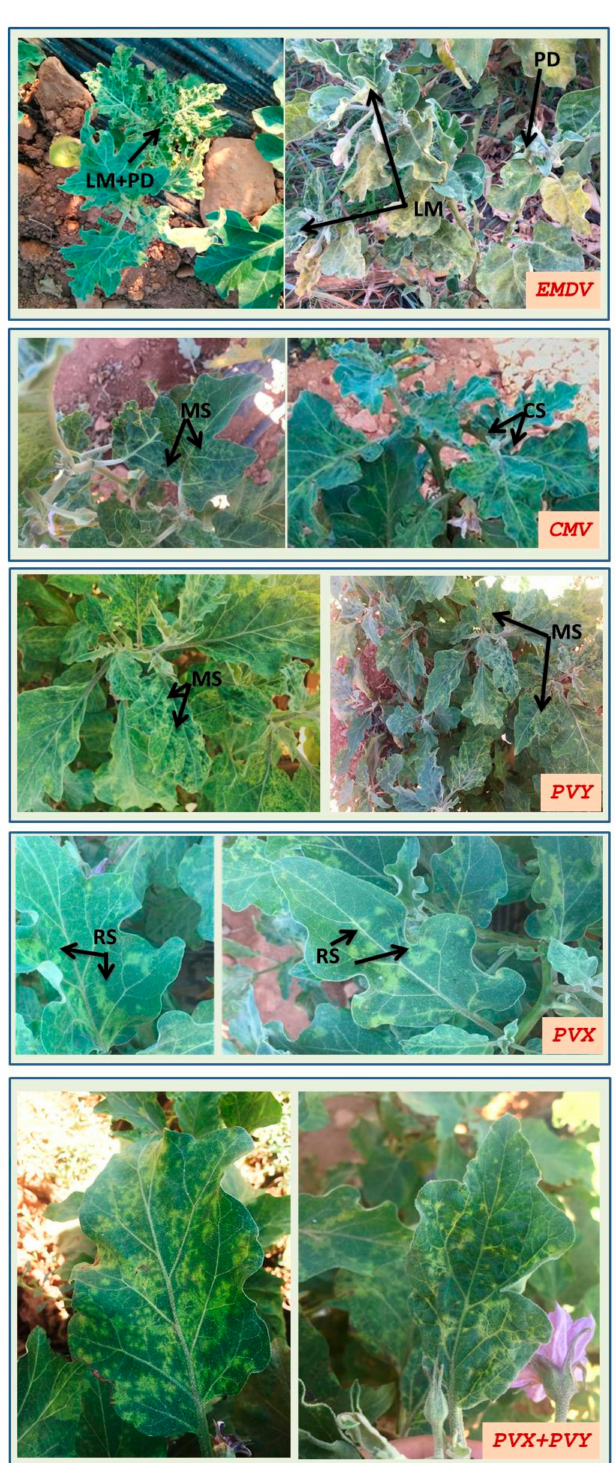
Figure 5. Disease symptoms on eggplant plants from Bekaa valley naturally infected with different viruses during the growing season of 2018. Symptoms consisted of leaf mottling (LM); plant dwarf (PD); chlorotic spots (CS); mosaic symptoms (MS) and ring spots (RS). Each detected virus in this study is indicated in Red. CMV, EMDV and PVY were found by ELISA test; PVX was detected by